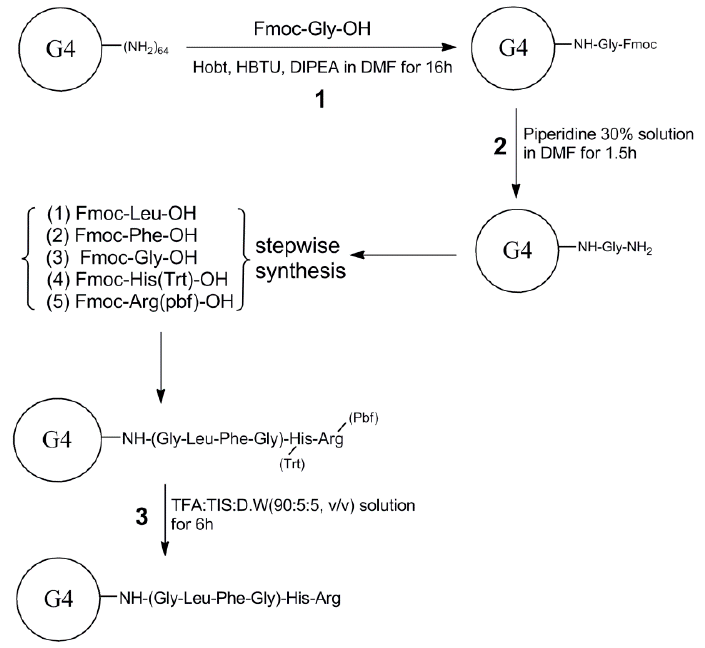
Figure 2. Synthesis scheme of PAMAM G4-GLFG-H-R. DIPEA: N , N -diisopropylethylamine; DMF: dimethylformamide; HBTU: 2-(1 H -benzotriazole-1-yl)-1,1,3,3-tetramethyluronium hexaafluoropho-sphate; HOBt: 1-hydroxybenzotriazole hydrate; TFA: trifluoroacetic acid; TIS: triisopropylsilane.